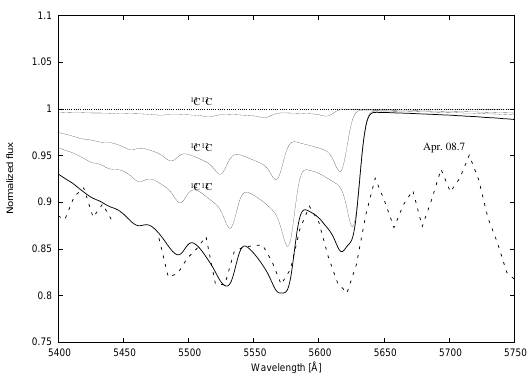
Figure 2: Comparison between observed and modeled spectra of the C 2 (∆v = -1) absorption band. The ob- served spectrum is shown by dashed line (the region influenced by the Hg emission from the city-light, at ∼ 5460 ˚A, has been removed). The modeled spectra for 13 C 13 C, 12 C 13 C and 12 C 12 C are shown by the thin solid lines and the sum of those lines is shown by the thick solid line. For the modeled spectra, we assumed the rotational and vibrational temperatures of 4500 K and the isotopic ratio of 12 C/ 13 C = 4. Figure 3: Multi band light curve of V2676 Oph (data